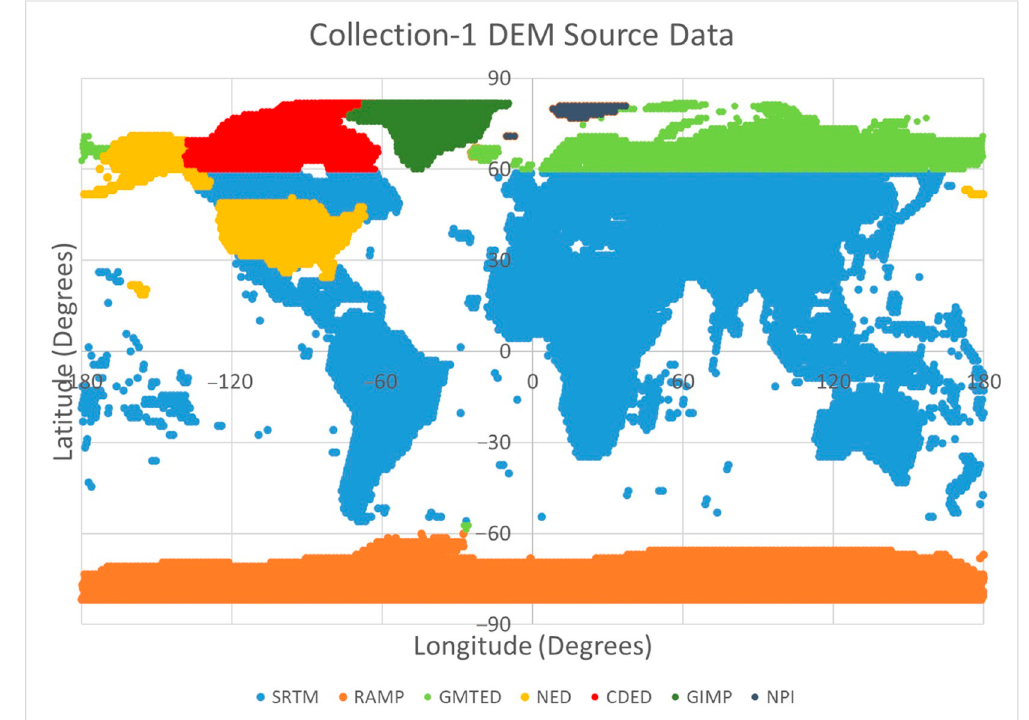
Figure 3. Landsat Collection-1 data sources.